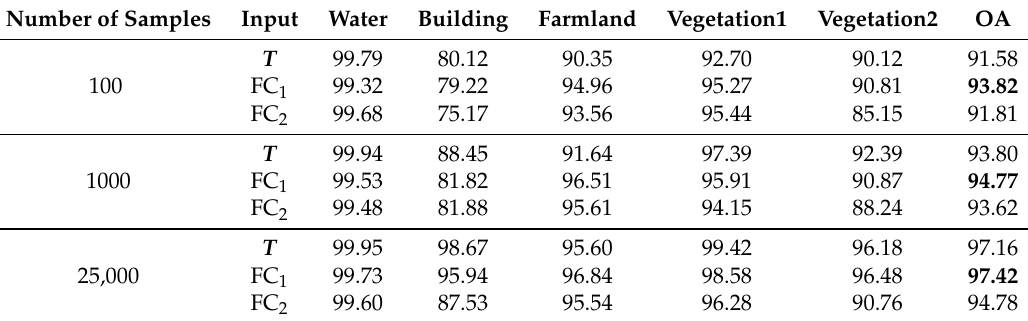
Table 6. The semi-supervised classification accuracies of GF-3 Wuhan (%). Number of Samples